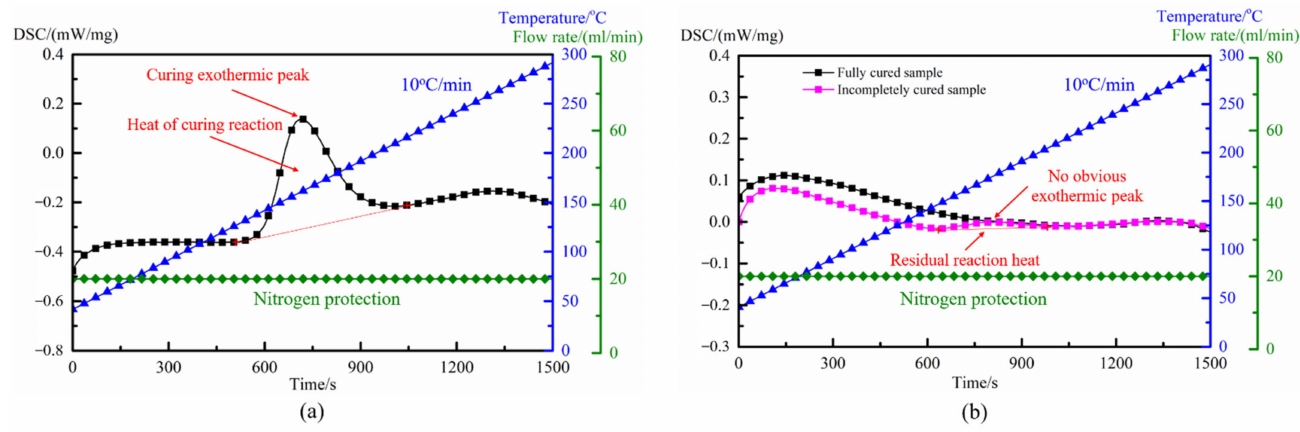
Figure 17. DSC curves: ( a ) uncured prepregs; ( b ) samples after microwave